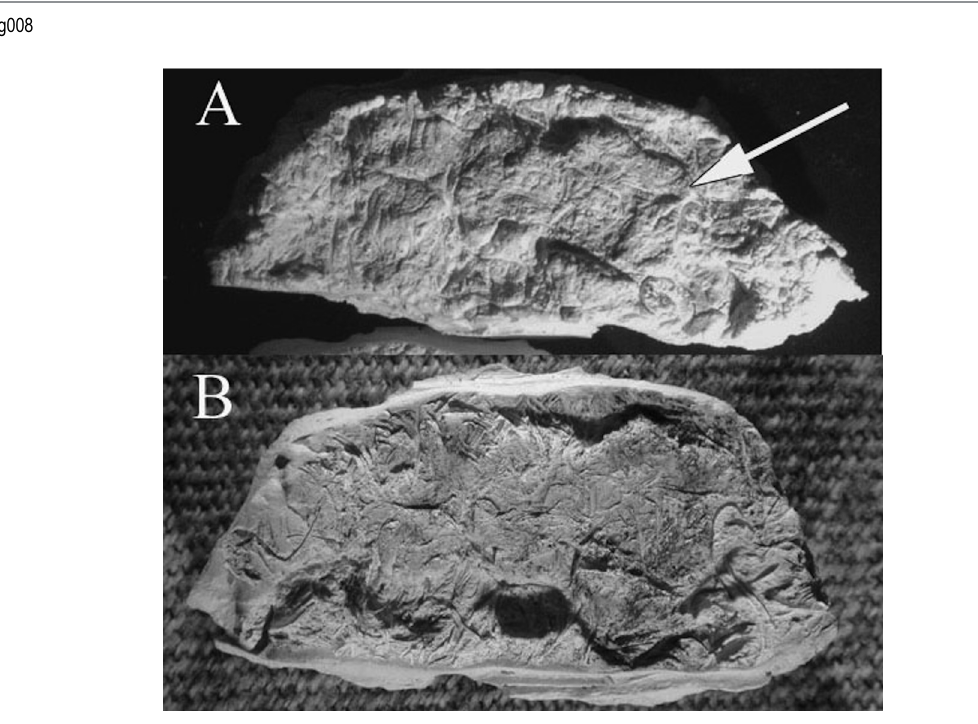
Fig 8. This shows the adult dental casts from three quids. Casts 8a and 8b show recognizable teeth with no apparent dental wear. 8c shows two casts made from the upper and lower sides of a single quid. This is the partial cast of the upper and lower dentition of a single individual. Scale is in centimeters and is for a and b only.